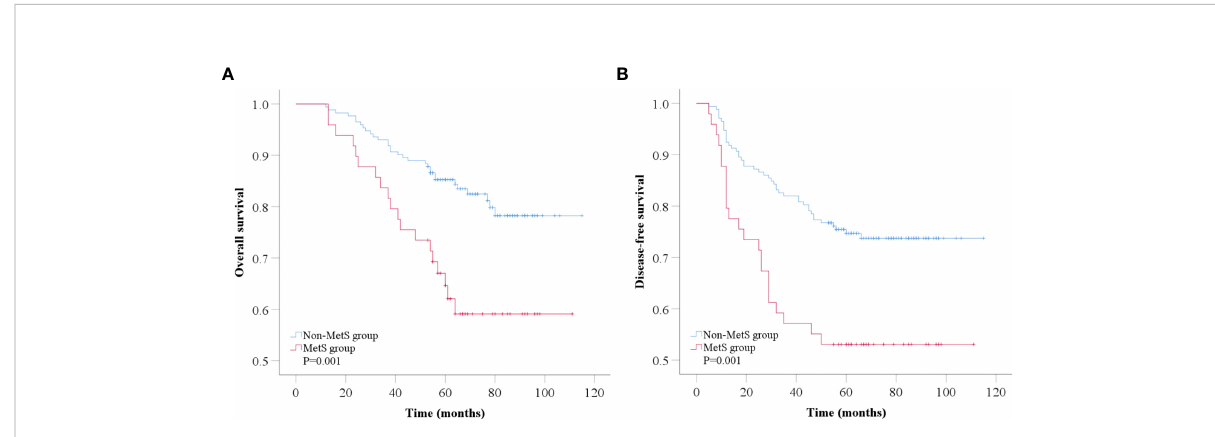
FIGURE 3 Kaplan-Meier analysis of overall survival (A) and disease-free survival (B) according to MetS status. MetS, metabolic